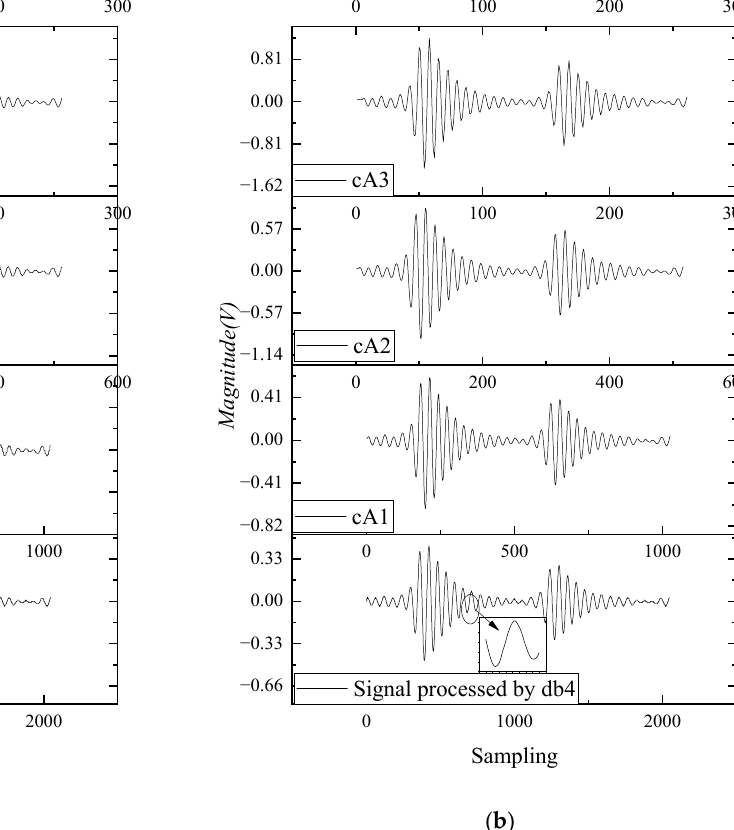
Figure 10. Signals processed with wavelet approximation coefficients for ( a ) db4 wavelet base and ( b ) haar wavelet base.